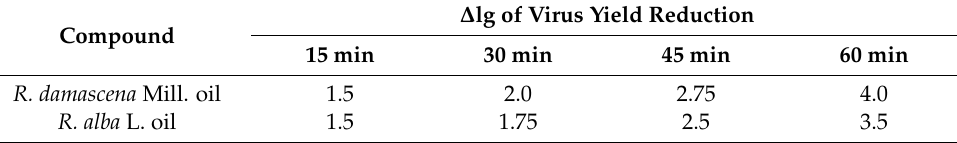
Table 3. Effect on the adsorption of HSV-1 (Victoria strain) of Rosa damascena Mill. and Rosa alba L. essential oils. Compound